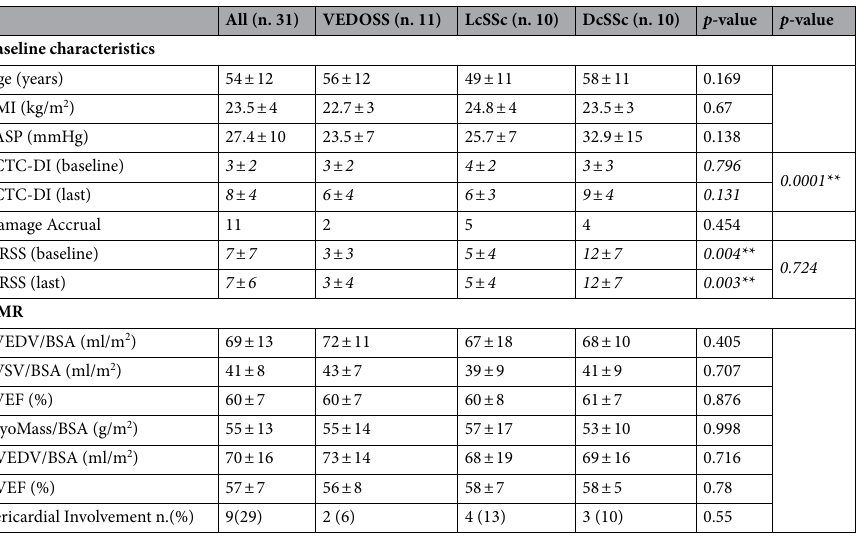
Table 1. Patients characteristics. VEDOSS: very early diagnosis of systemic sclerosis; LsSSc: Limited cutaneous Systemic Sclerosis; DcSSc: Diffuse cutaneous Systemic Sclerosis; BMI: body mass index; PASP: pulmonary artery systolic pressure; SCTC-DI: Scleroderma Clinical Trial Consortium Damage Index; mRSS: modified Rodnan Skin Score; CMR: cardiac magnetic resonance; LVEDV: left ventricular end-diastolic volume; BSA: body surface area; LVSV: left ventricular systolic volume; LVEF: left ventricular ejection fraction; MyoMass: myocardial mass; RVEDV: right ventricular end-diastolic volume; RVEF: right ventricular ejection fraction; SSc: systemic sclerosis. **Significant test; p -value less than 0.01. In italic, SCTC-DI and mRSS were respectively paired for baseline and at last follow-up values. First p-value refers to the per subset analysis. In the last column, comparison between paired overall values.